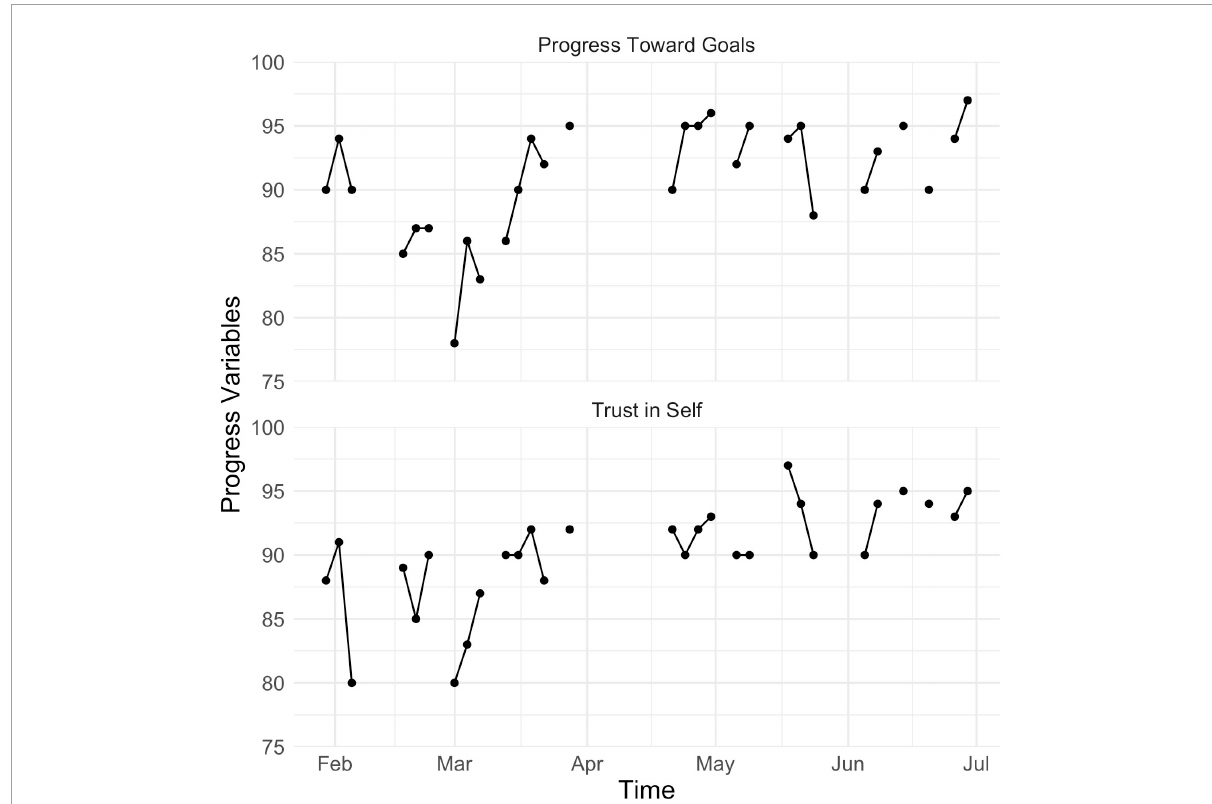
FIGURE7 Amy’s scores for self-rated progress toward goals and degree of trust in herself from mid- to posttreatment.